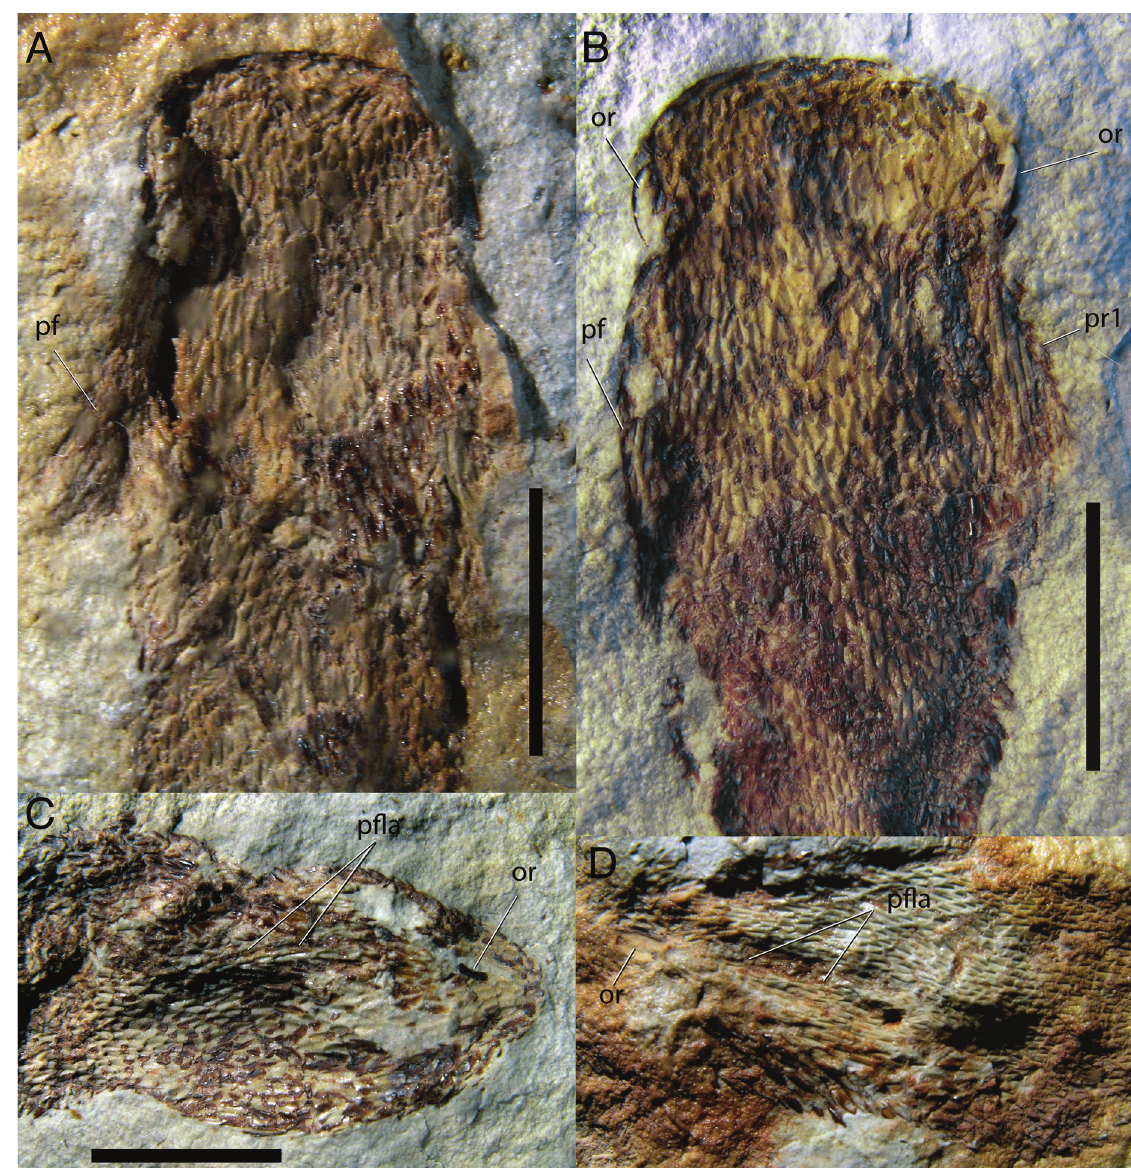
Fig. 6. Phlebolepis elegans Pander. Specimens showing pectoral fin, from Himmiste-Kuigu, Saaremaa, Estonia, imaged wet. A , TUG 865-28-4; B , TUG 865-9-2 (counterpart of Fig. 4A); C , TUG 865-1-3; D , TUG 865-16-10. Scale bars are each 1 cm. Abbreviations: or, orbital scales; pf, pectoral fin; pfla, pectoral fin line of attachment; pr1, first (outer, leading edge) pectoral fin